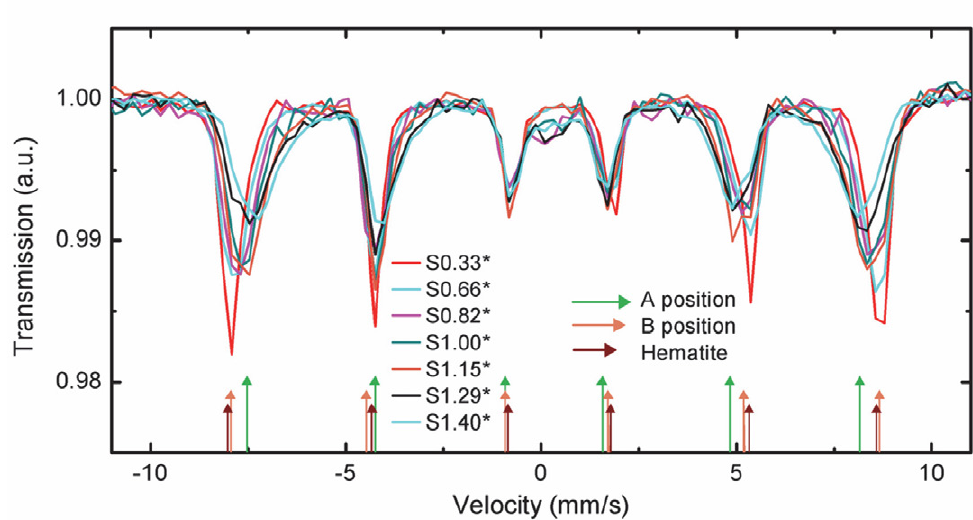
Figure 7. Transmission spectra of S0.33*, S0.66*, S0.82*, S1.00*, S1.15*, S1.29* and S1.40*